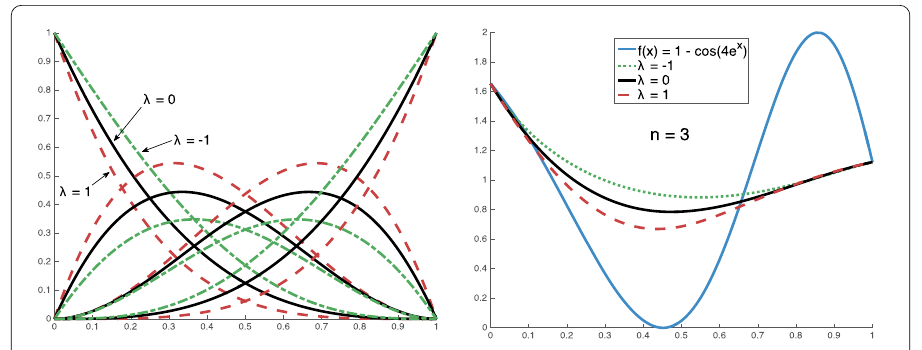
Figure 1 The graphs of ˜ b 3, k ( λ ; x ) with different values of λ (left) and their corresponding B 3, λ ( f ; x )